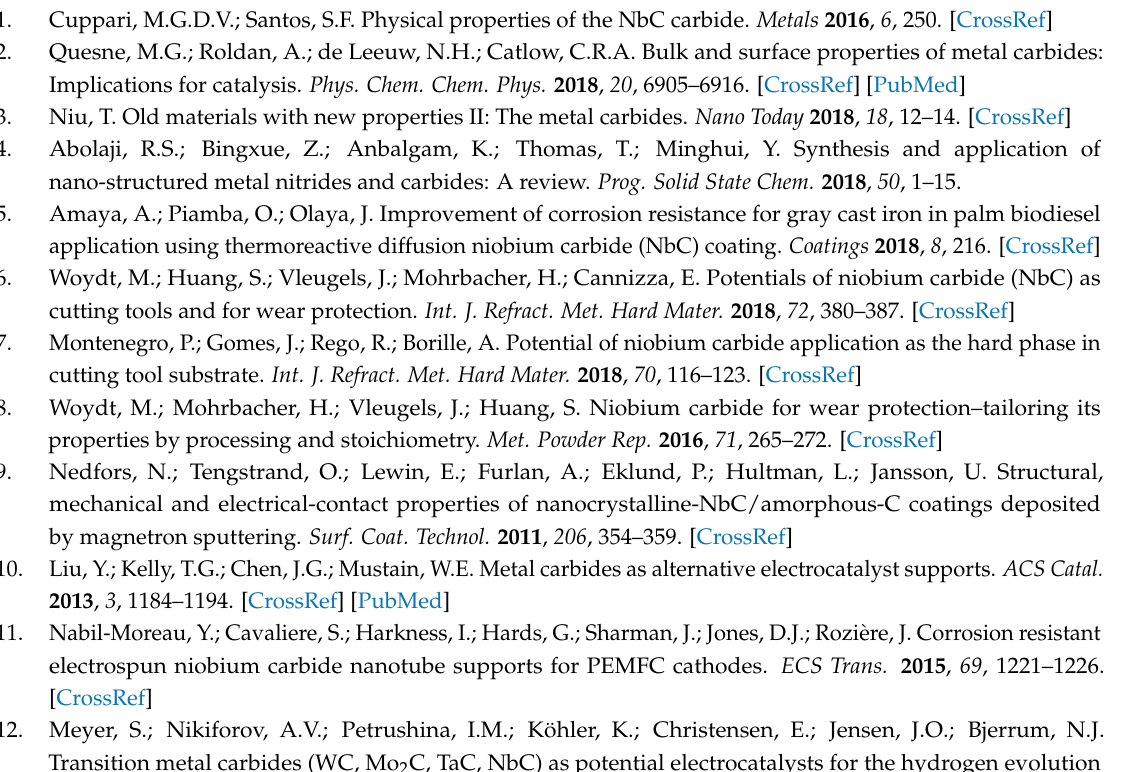
Figure S1: XRD patterns (logarithmic scale) of NbC films grown at different conditions; Figure S2: (a) X-ray pole figure of the NbC/c-sapphire system measured at a 2 θ angle of 58.34 ◦ for the NbC (220) peak; (b) Azimuthal ( ϕ ) scan data measured at a χ angle of 35 ◦ ; Figure S3: Cross-sectional SEM images of NbC